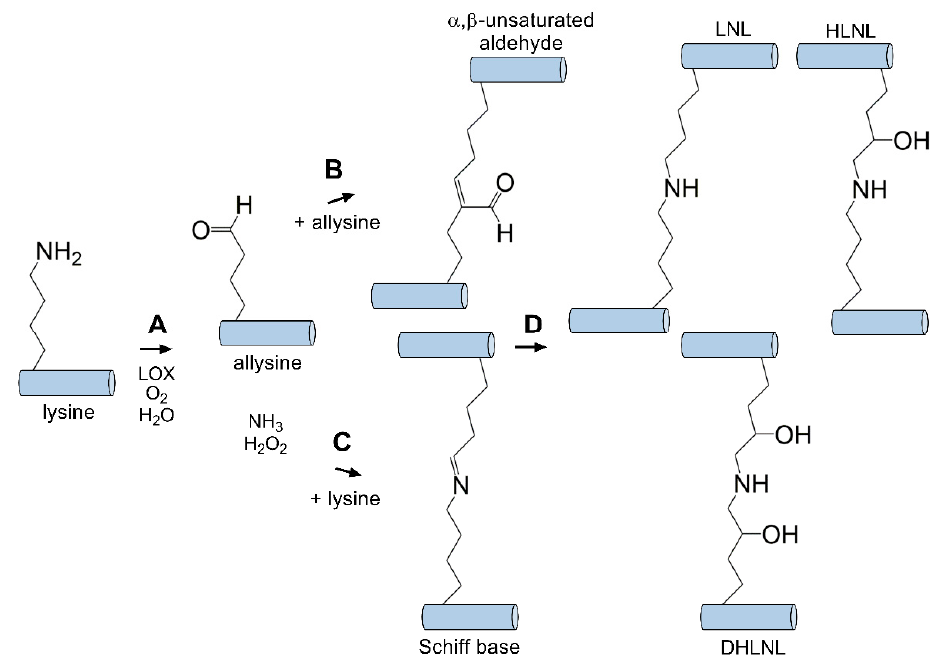
Figure 3. Lysyl oxidase (LOX) mediates intermolecular crosslinks between tropocollagen molecules. ( A ) LOX catalyzes the conversion of a primary amine to an aldehyde (allysine). This intermediate can then react with an adjacent ( B ) aldhyde (allysine) or ( C ) primary amine (lysine) to generate an α , β -unsaturated aldehyde or Schiff base intermediate, respectively. ( D ) Condensation generates stable covalently bound crosslinks (e.g., lysinonorleucine (LNL), dihydroxylysinorleucine (DHLNL), hydroxylysinonorleucine (HLNL) [166,167] ) between tropocollagen molecules.